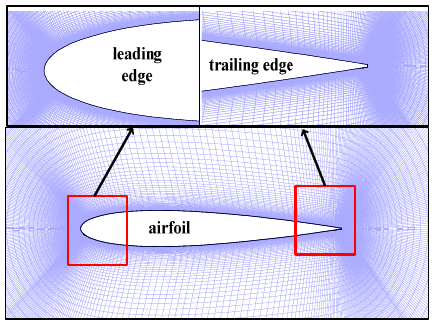
Figure 1. Airfoil boundary layer mesh.